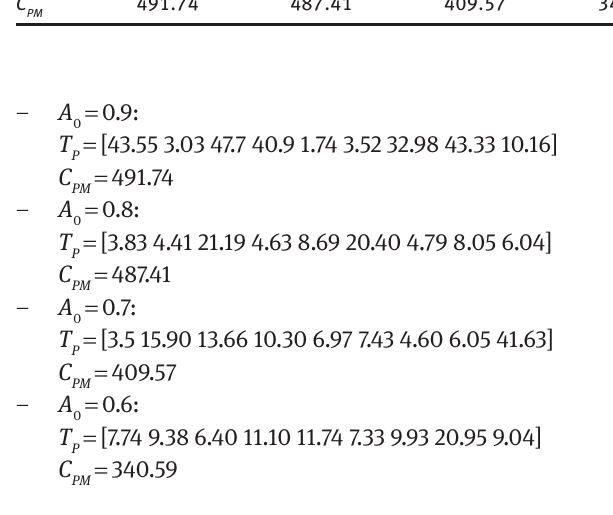
Table 5: PM Cost for Different Values of A A 0